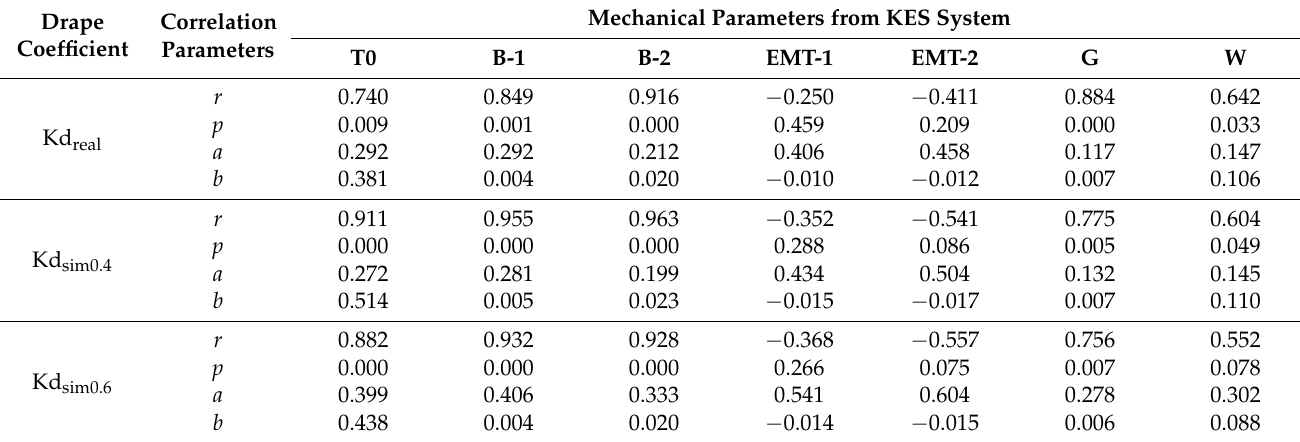
Table 7. Linear correlation analysis of the parameters of physical and mechanical properties influences the value of the drape coefficient of real and simulated